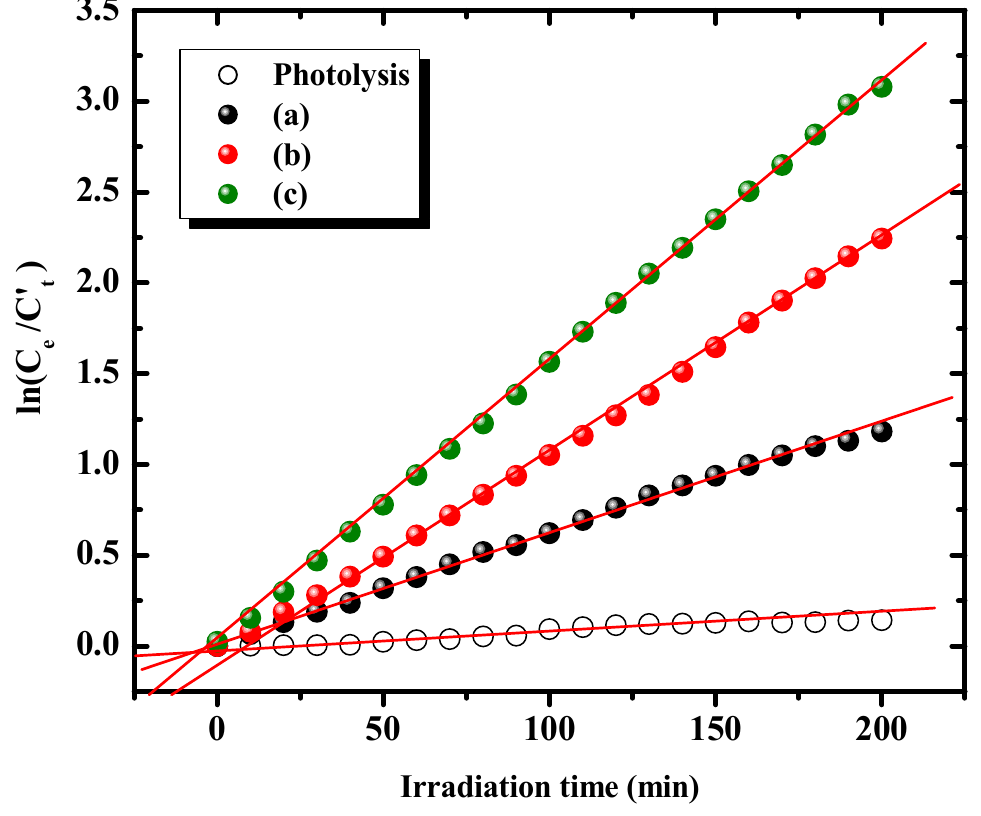
Figure 10. Pseudo first-order kinetics of MB photodegradation catalyzed by BiFeVOx.y for ( a ) y = 0.03, ( b ) y = 0.07, and ( c ) y = 0.15, under visible light irradiation.